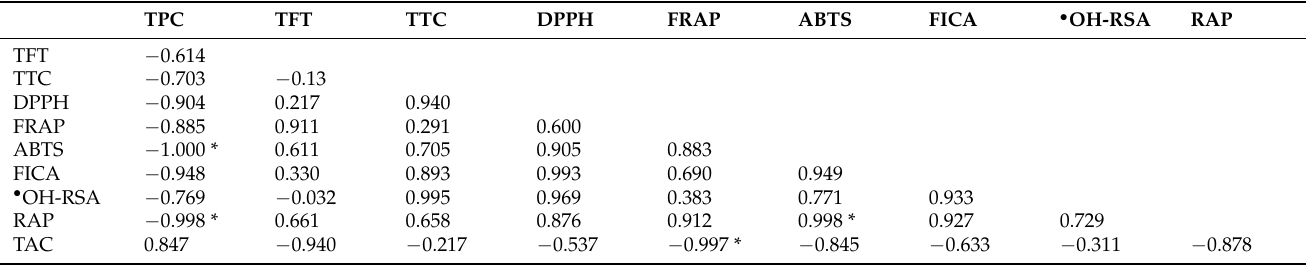
Table 3. Pearson’s correlation between the antioxidant capacities given by different antioxidant